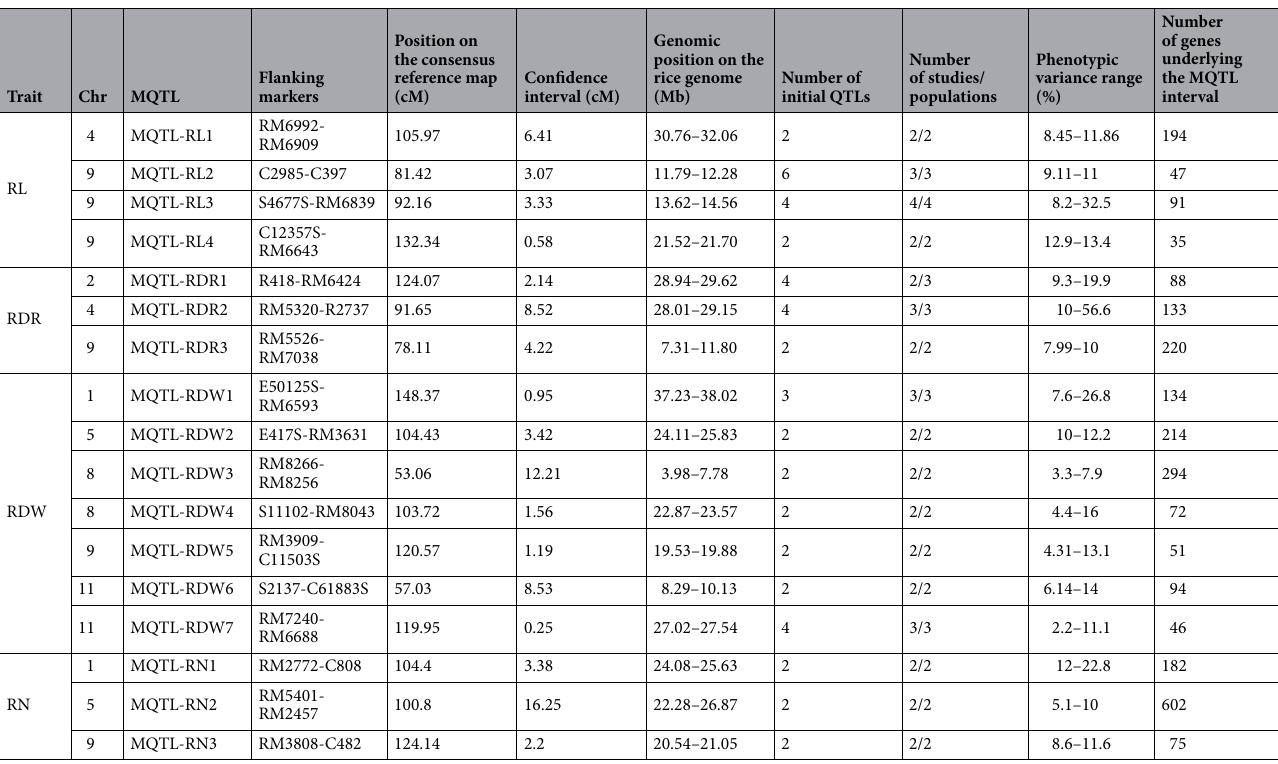
Table 3. Summary of the detected MQTLs for YLD, GW, HD, PH, TN, DT, RT, RL, RDR, RDW and RN traits in rice under water deficit condition. YLD yield, GW grain weight, PH plant height, HD heading date, TN